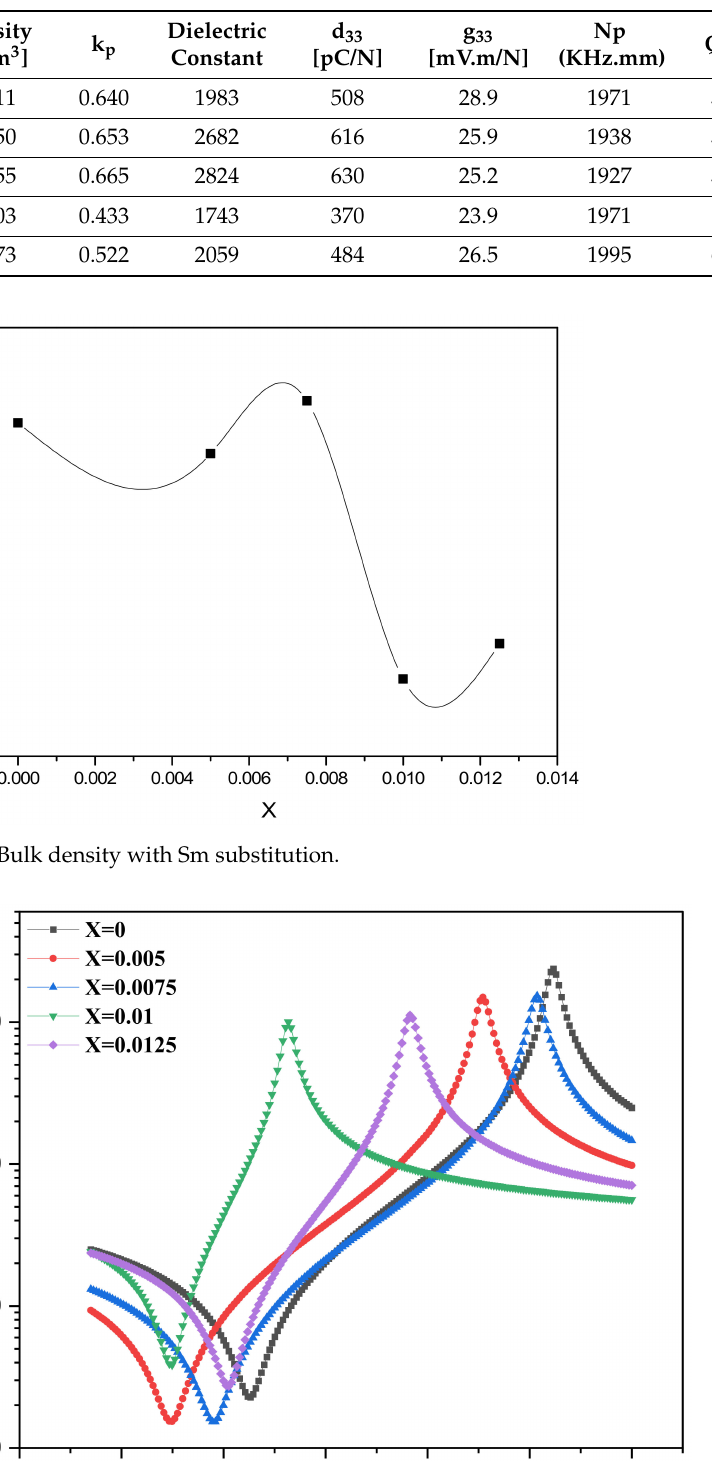
Table 1. Physical properties with Sm substitution.